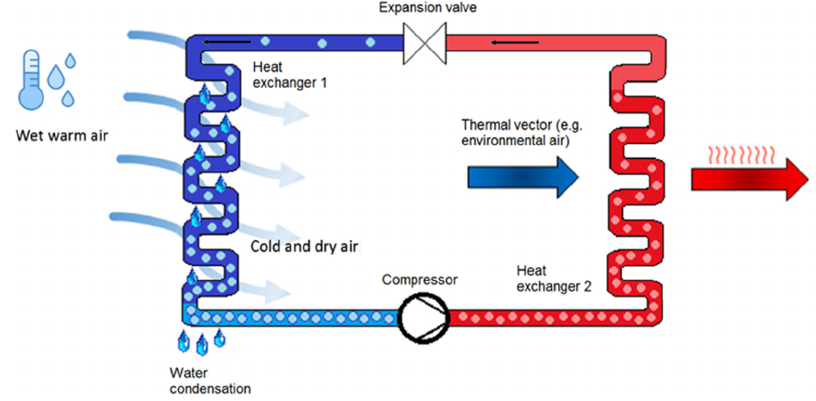
Energies 2022 , 15 , x FOR PEER REVIEW Figure 1. Reverse cycle-based AWG working scheme, image from [6]. Figure 1. Reverse cycle-based AWG working scheme, image from [6].